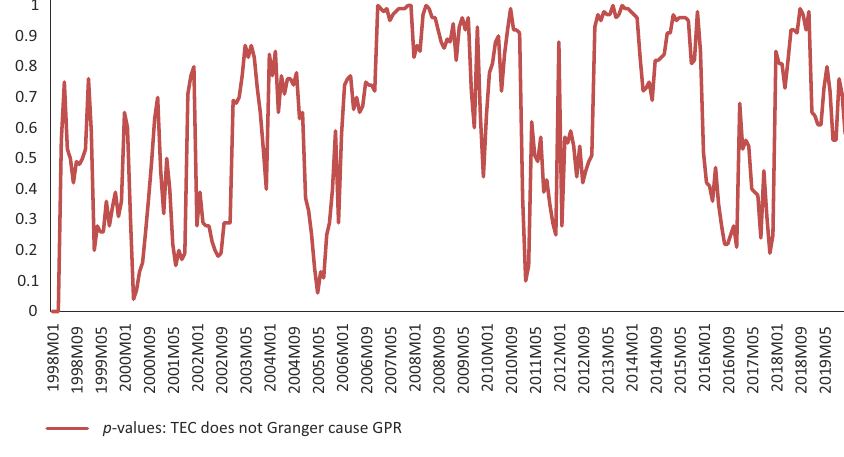
Figure 4. TEC causal impact on GPR